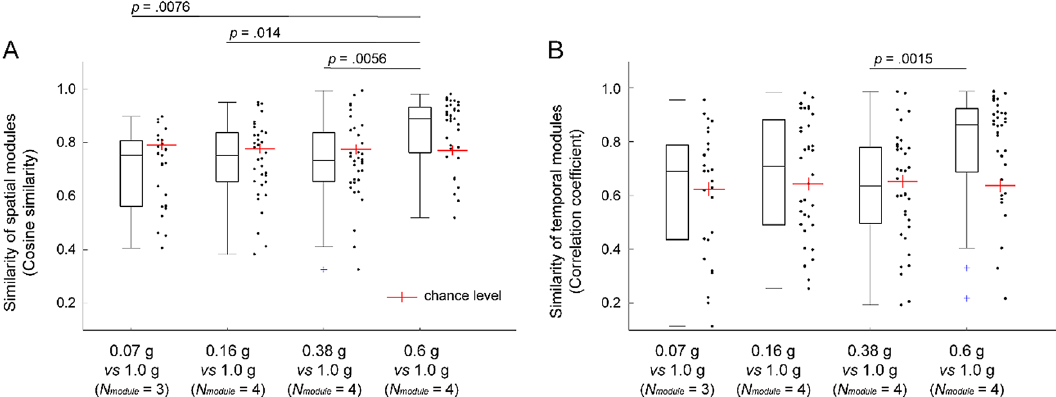
Figure 7. Structural change in the modules. The similarity of the spatial ( A ) and temporal ( B ) modules between the gravity condition of 1 g and each of the remaining gravity levels was calculated across all pairs of modules that were matched to each other by maximizing the cosine similarity between each spatial module pair and the correlation coefficient between each temporal module pair. Each dot indicates the similarity of each module pair, and the boxplot represents their distribution. The red crossed line indicates the chance